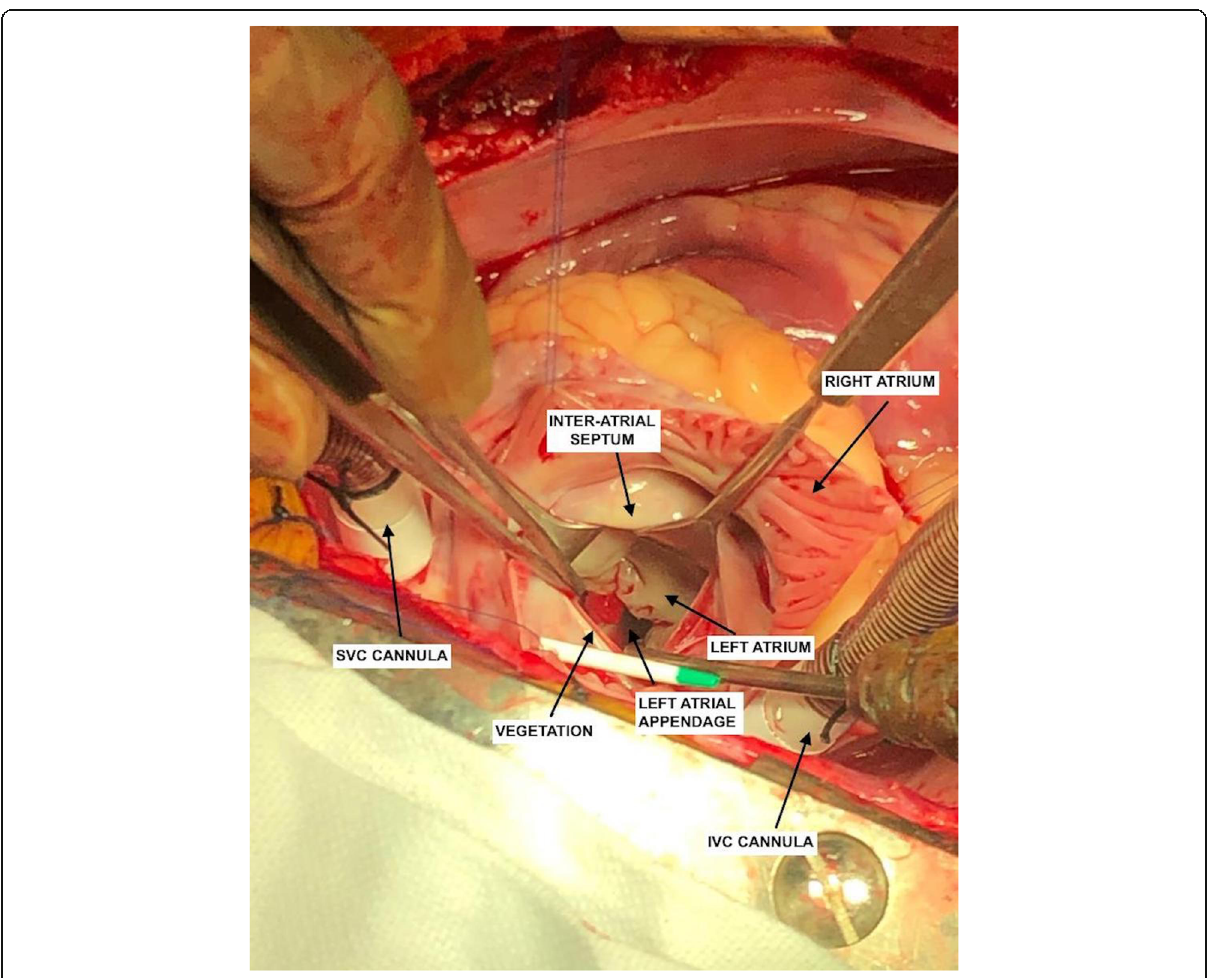
Fig. 4 Intra-operative surgical image showing the